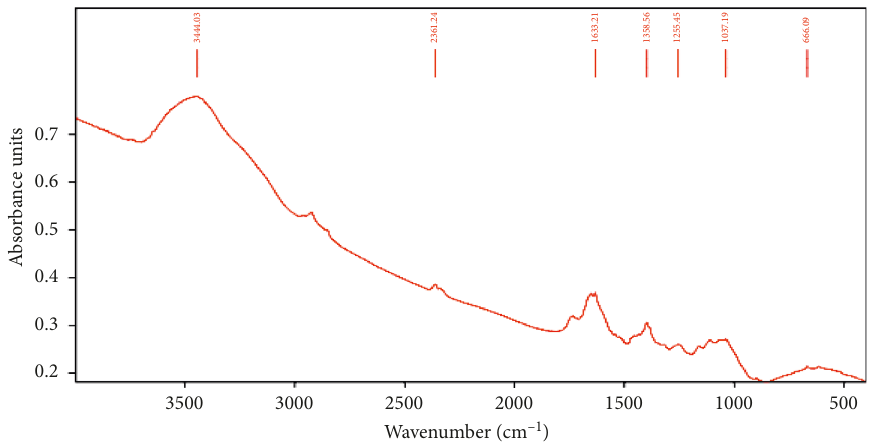
Figure 3: FTIR spectra of PB (reproduced from Fegousse et al.